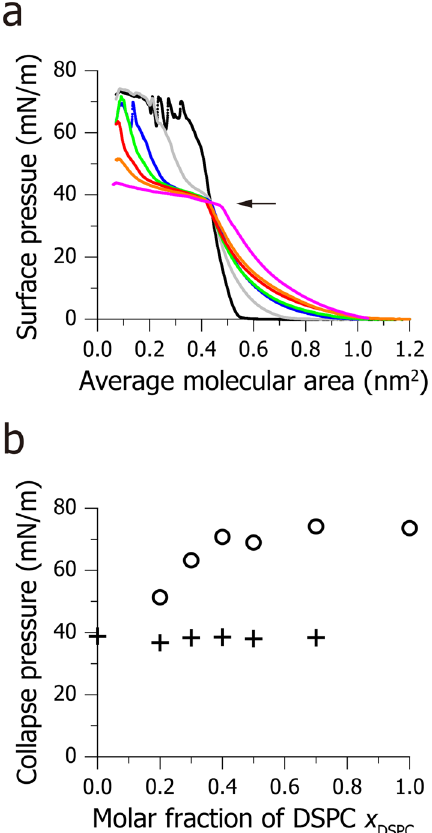
Figure 4. Composition-dependent phase behaviour of DSPC/DOPC binary monolayers. ( a ) π – A isotherms of DSPC/DOPC binary monolayers at different mole fractions of DSPC ( x DSPC ). x DSPC = 0 (pink), 0.2 (orange), 0.3 (red), 0.4 (green), 0.5 (blue), 0.7 (grey), and 1.0 (black). An arrow indicated the collapse pressure of the disordered domains. ( b ) Collapse pressure vs. composition plot. The circles and crosses show the collapse pressure of the ordered and disordered domains,